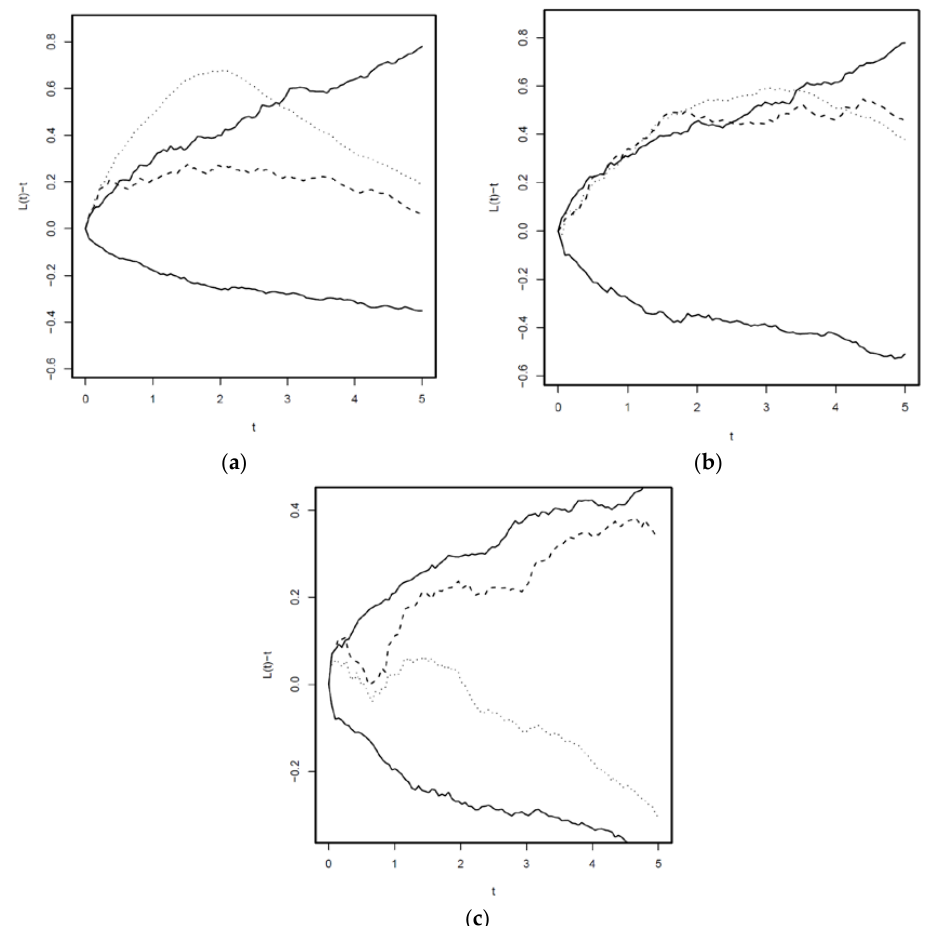
Figure 5. Cross L(t)—functions of tree seedlings. ( a ): Fagus sylvatica and Abies alba ; ( b ): Fagus sylvatica and Picea abies , ( c ): Abies alba and Picea abies. Solid lines: 95% envelopes generated assuming data realizations of independent inhomogeneous cluster processes. Dotted line: L-function computed assuming homogeneous distribution of points. Dashed: L-function computed taking into account inhomogeneity due to covariates.